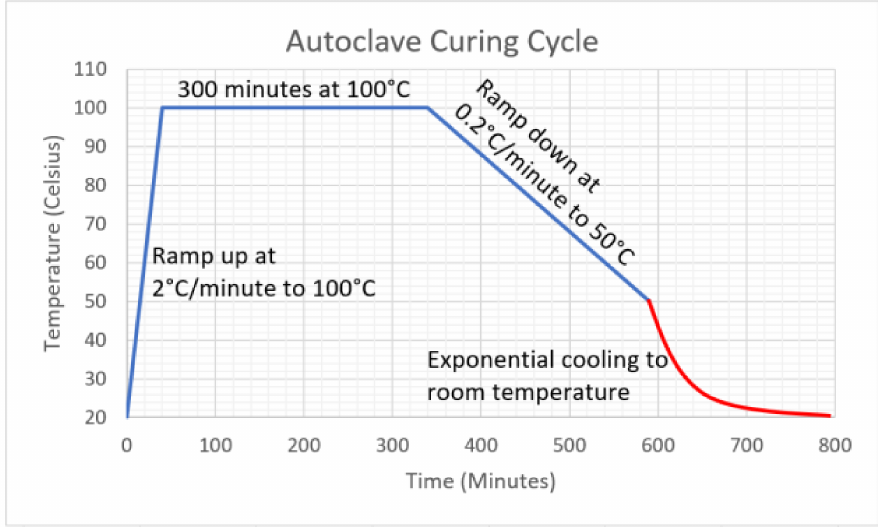
Figure 4. Autoclave cooling